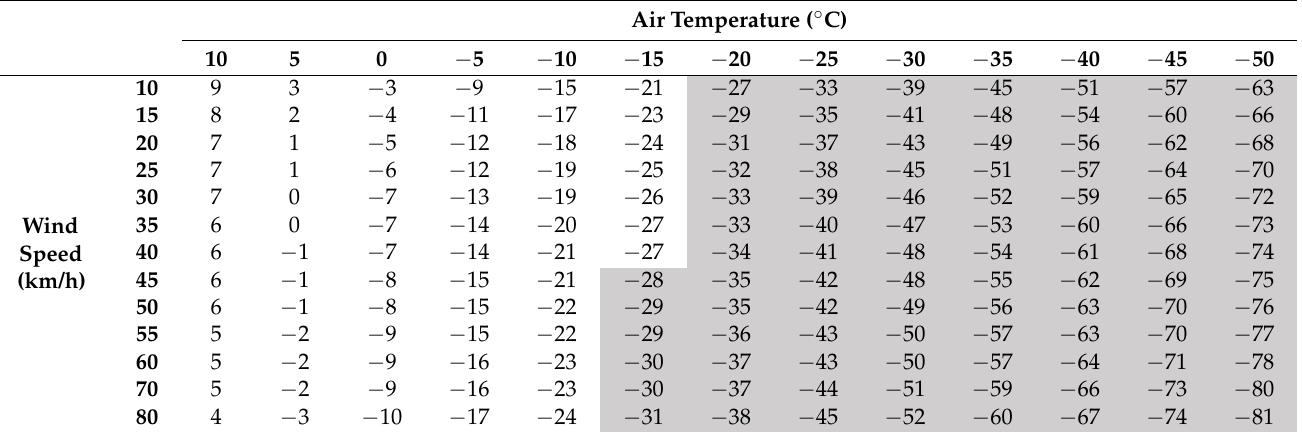
Table 1 has been generated using Equation (2). The table is used to determine whether the workers at WFs in CCRs are subjected to the risk of frostbite or not, where the shaded region indicates an increasing risk of frostbite [34]. Table 1. Wind chill temperature (WCT) chart.